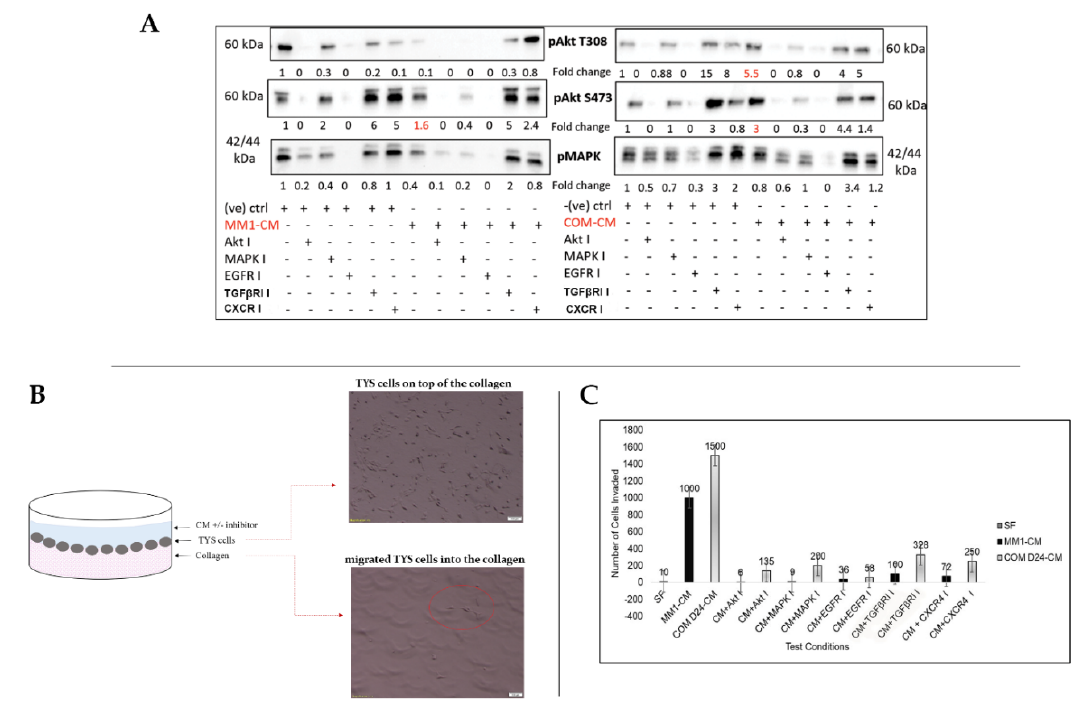
Figure 2. Activation of Akt and MAPK in scattered TYS cells and migration of TYS into the matrix. ( A ) Phosphorylated Akt at Threonine 308 (pAkt T308) and Serine 473 (pAkt S473) and phoshorylated42 / 44-MAPK in TYS cells after 48 h of the scatter assay. COM-CM activated Akt in scattered TYS cells (red font) more than the negative control and MM1-CM. Fibroblast CM did not activate MAPK in TYS cells after 48 h. Blots were normalised against total protein, quantified, and the data expressed as the fold change compared to the negative control. SF-MEM-treated TYS cells in the scatter assay after 48 h were regarded as the negative control. ( B ) Graphical representation of the collagen gel migration assay in which TYS cells were plated on top of collagen gels followed by treatment with CM ± inhibitors. Cells that had migrated (red circle) into the collagen were counted manually by selecting 5 random areas within the gel after 48 h. ( C ) Bar graph representing the number of TYS cells that migrated into the matrix in response to fibroblast CM with or without inhibitors. COM-CM stimulated TYS cell migration into the matrix more than the negative control (SF-MEM-treated cells) and that of MM1-CM. The Akt and EGFR inhibitors were the most e ff ective inhibitors in blocking CM-induced TYS cell migration.